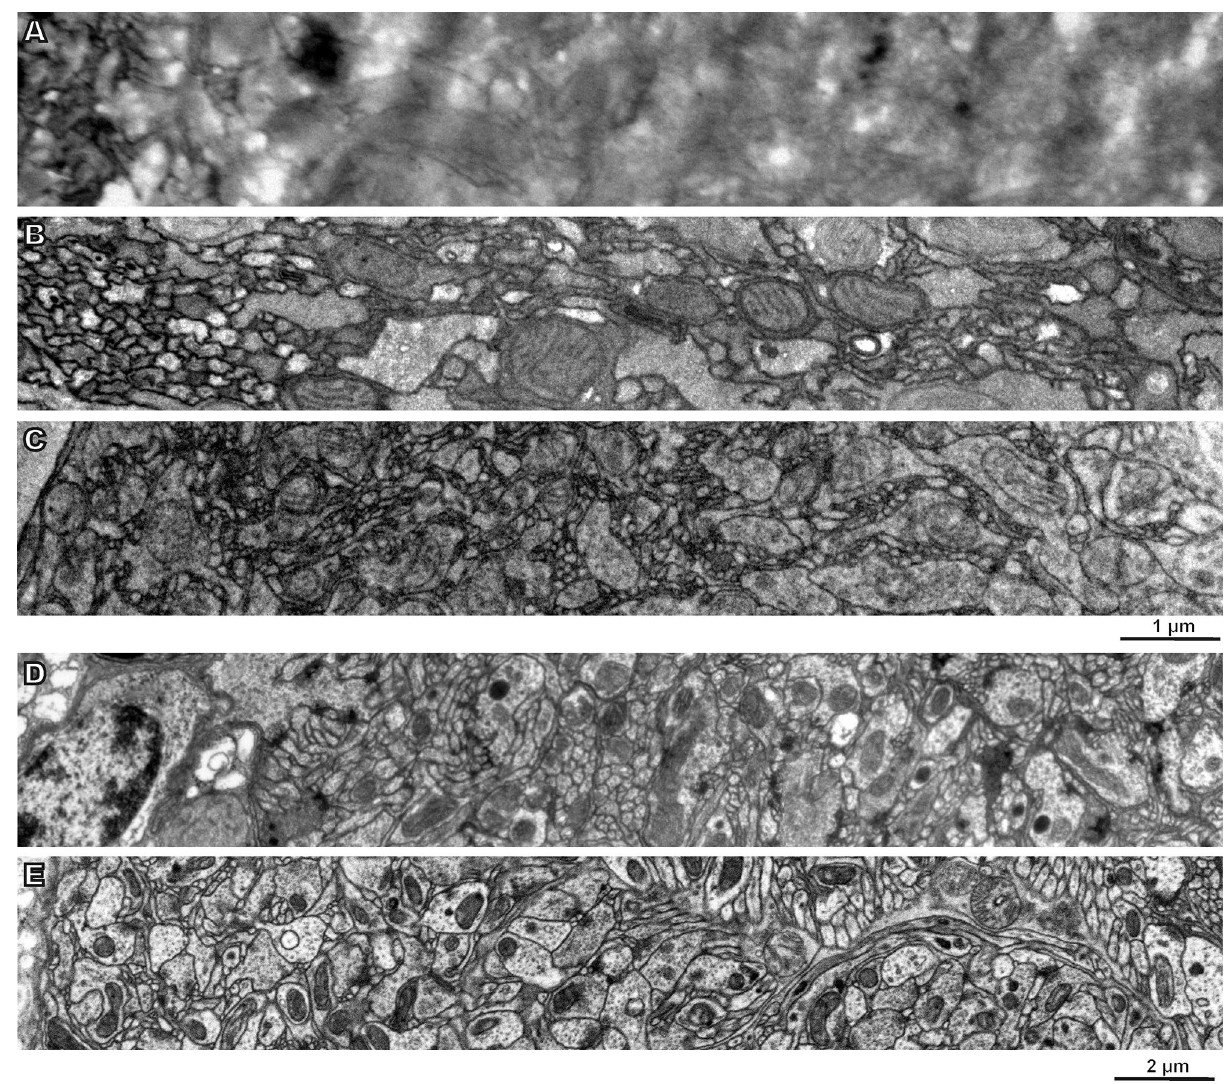
Figure 2. Comparison of the homogeneity of contrasting for samples of the brain of the parasitoid wasp Megaphragma amalphitanum from peripheral regions (left) to central regions (right) in samples prepared according to different protocols (TEM). ( A ) RO and TA 13 ; ( B ) ROTO, UA, PbAsp 35 ; ( C ) Permanganate 36 ; ( D ) PLT 16 ; ( E ) our